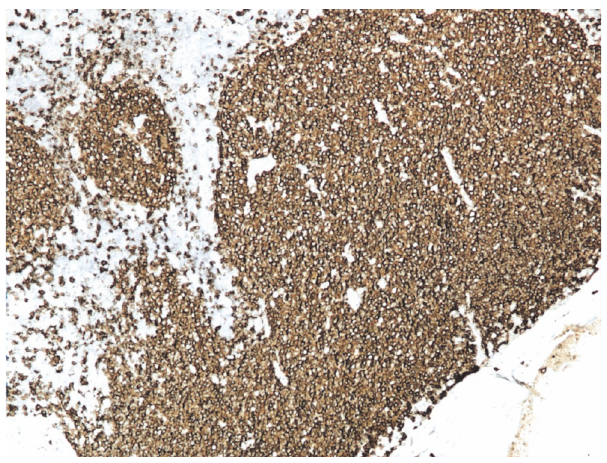
Figure7:Mantlecelllymphoma(100x).Positivestainingwithcyclin D1.